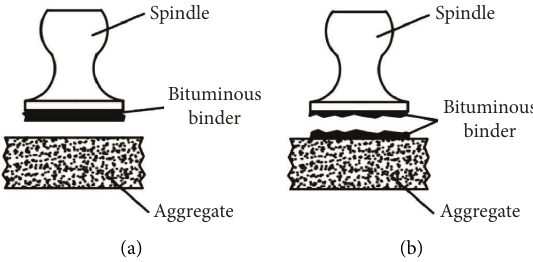
Figure 1: Schematic of adhesive failure and cohesive failure. (a) Adhesion failure. (b) Cohesion